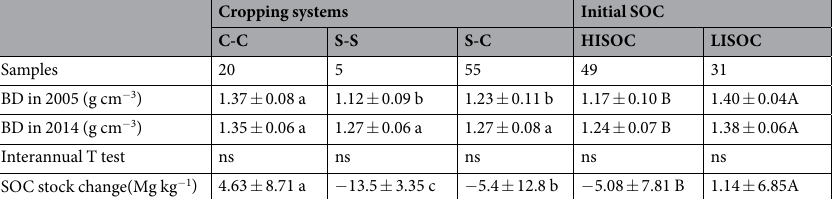
Table 1. Comparison of SOC stock change and BD change between different cropping system in both 2005 and 2014. HISOC: the samples with SOC ≥ 20 g kg − 1 in 2005; LISOC: the samples with SOC < 20 g kg − 1 in 2005; BD: bulk density; ns: no significant difference. Data are means ± SD. Year treatment indicates the comparison of average BD between 2005 and 2014. Within a line, cropping systems means followed by the same letter are not significantly ( P < 0.05).